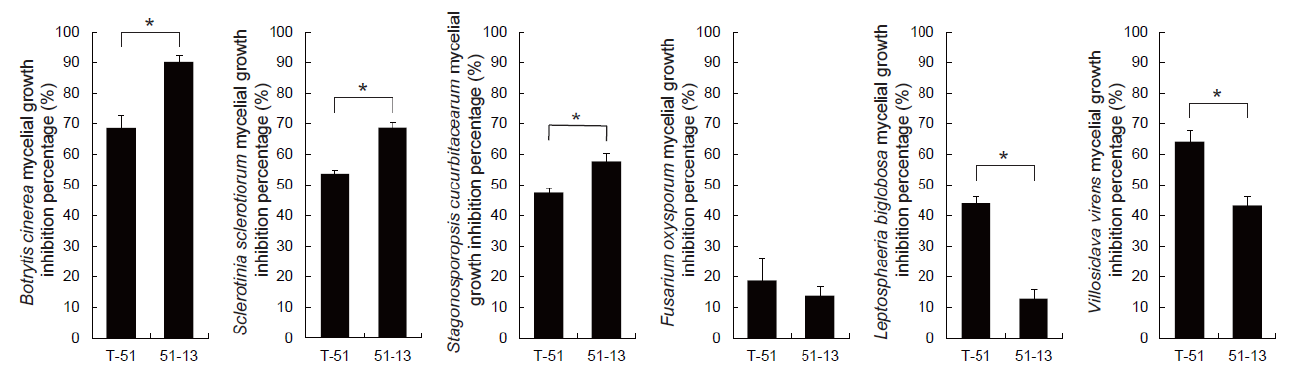
Figure 2. Inhibition of mycelial growth of various plant pathogenic fungi by the CF of T-51 and 51-13. * p < 0.05; student’s t -test.